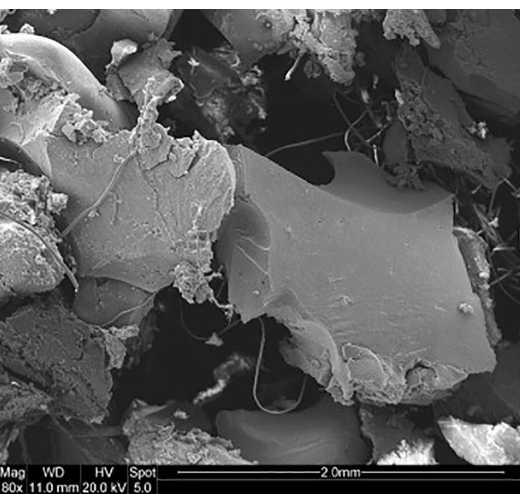
Figure 9. CR particle at 80× magnification [104].